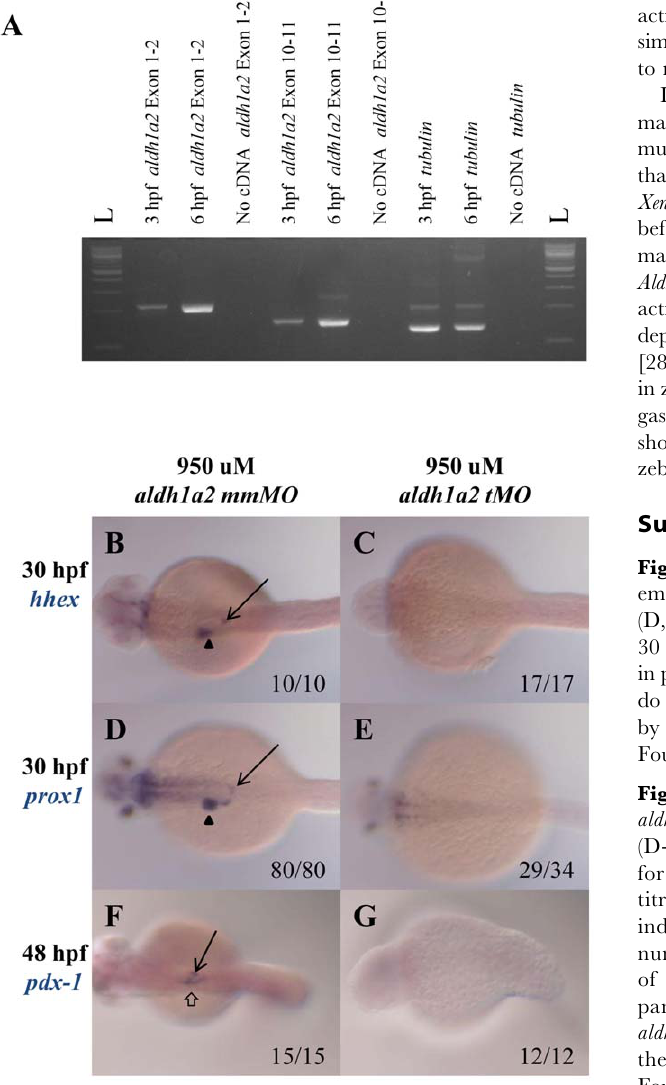
panels I, J) produce similar phenotypes to the aldh1a2 um22 and